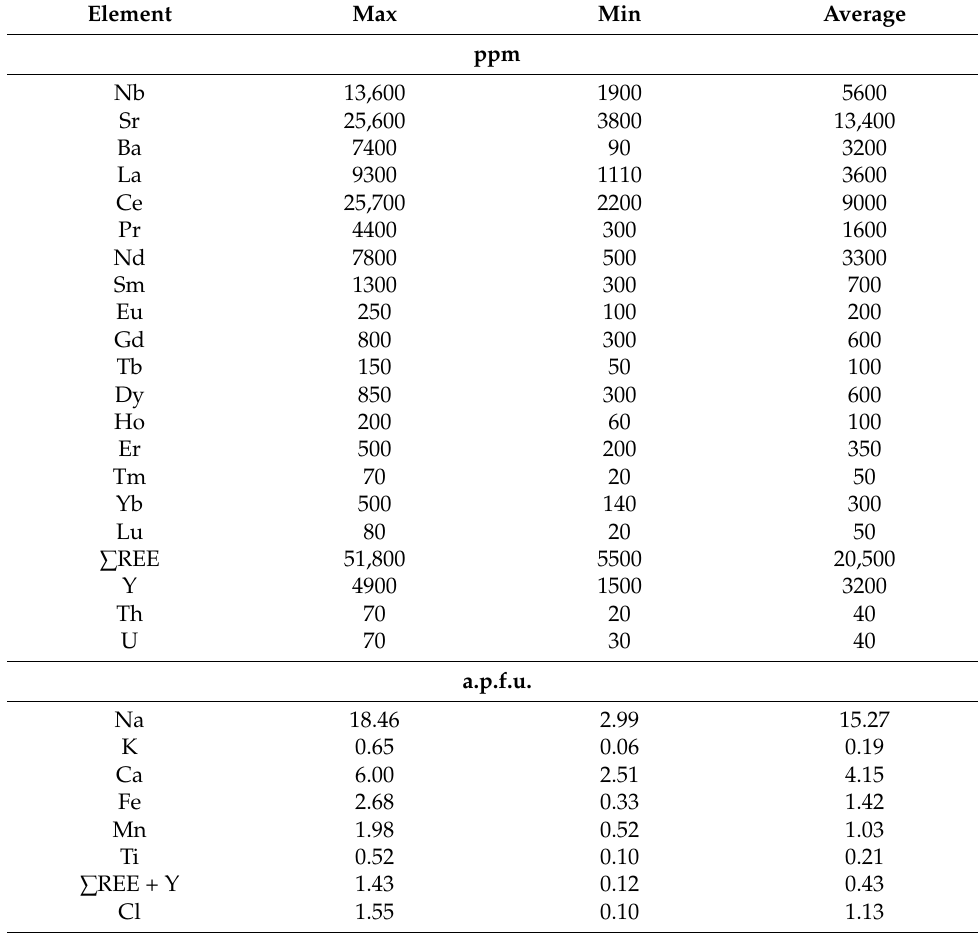
Table 1. Average compositions of EGM in Lovozero rocks.